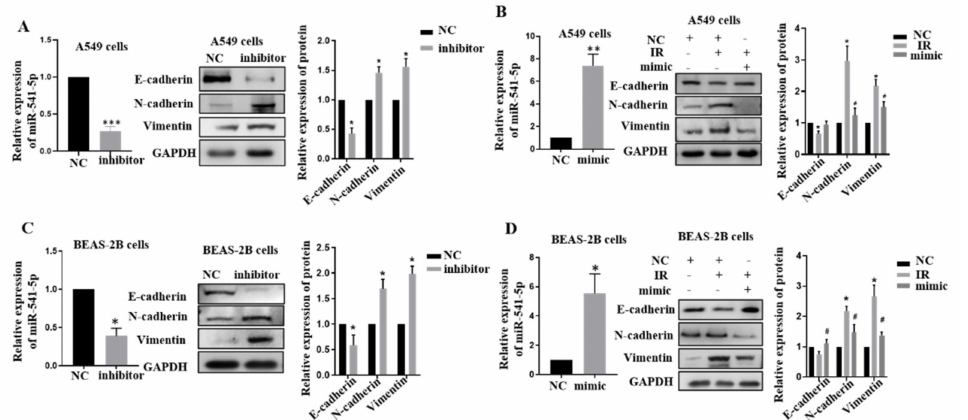
Figure 2. IR downregulated miR–541–5p to promote EMT. ( A ) Real-time PCR analysis verified the transfection efficiency of the miR–541–5p inhibitor (50 nm) in A549 cells. Detection of EMT-related protein changes after 48 h transfection by WB. The bar graph on the right shows the quantitative analysis of the protein using ImageJ. ( B ) Real-time PCR verified the transfection efficiency of the miR–541–5p mimic (50 nm) in A549 cells. Right: Re–overexpression of miR–541–5p after irradiation to observe the changes in the EMT-related proteins and the quantitative analysis of these proteins. Real-time PCR verified the transfection efficiency of the miR–541–5p inhibitor ( C )/mimic ( D ) in Beas 2B cells. Detection of EMT–related protein changes after 48 h transfection by WB. The bar graph on the right shows the quantitative analysis of the protein using ImageJ. The bar graphs show the gray value analysis. * p < 0.05 versus the control; # p < 0.05 versus IR. ** p < 0.01, *** p <